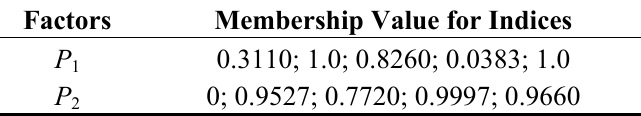
Table 5. Membership degrees to assessing